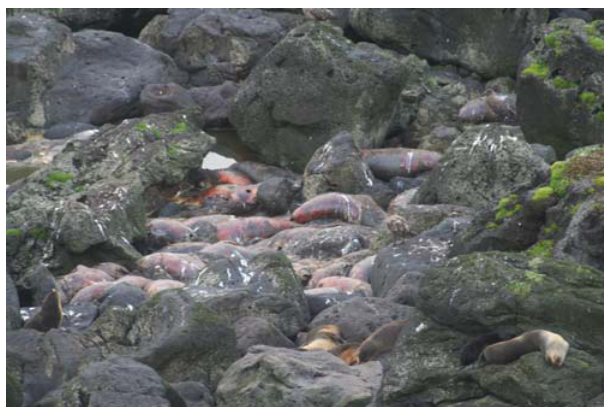
Figure 1. The carcasses of some male sub-Antarctic fur seals at a section of Fur Seal Peninsula at Marion Island. Photo taken three weeks after the die-off event by PJN de Bruyn.